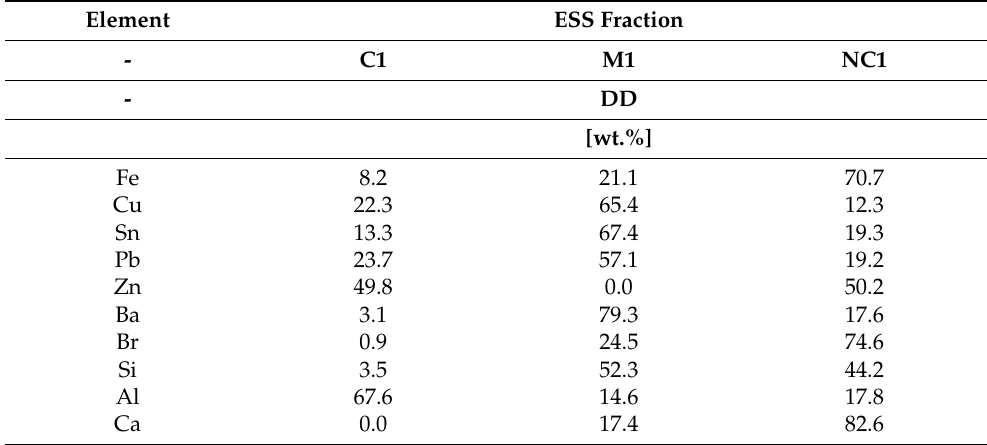
Table 10. Distribution of elements by fractions C1, M1, and